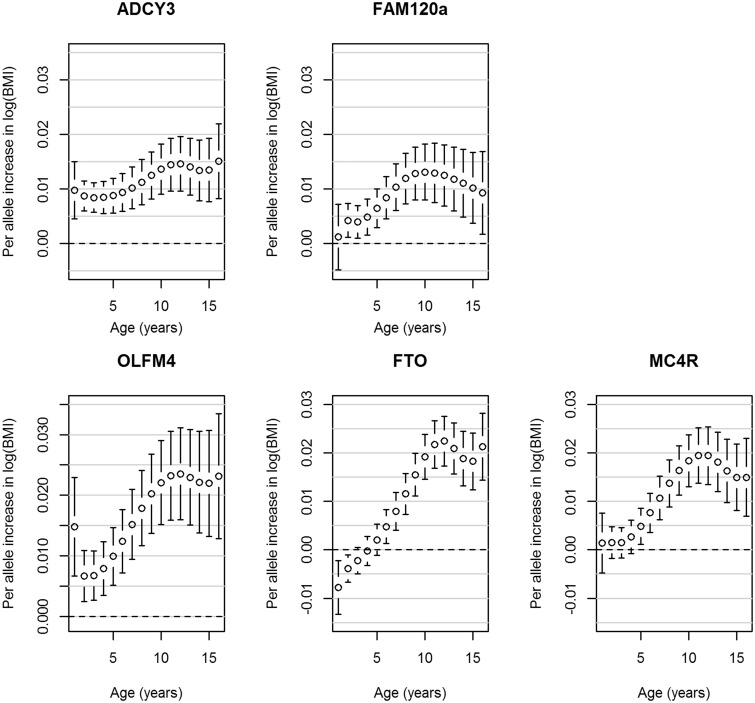
Associations from the ALSPAC cohort between the genome-wide significant SNPs and BMI from age one to 16 years. Error bars represent the regression coefficient of BMI on the natural log scale and 95% confidence intervals derived from the longitudinal additive genetic models. The SNPs are aligned to the minor allele.